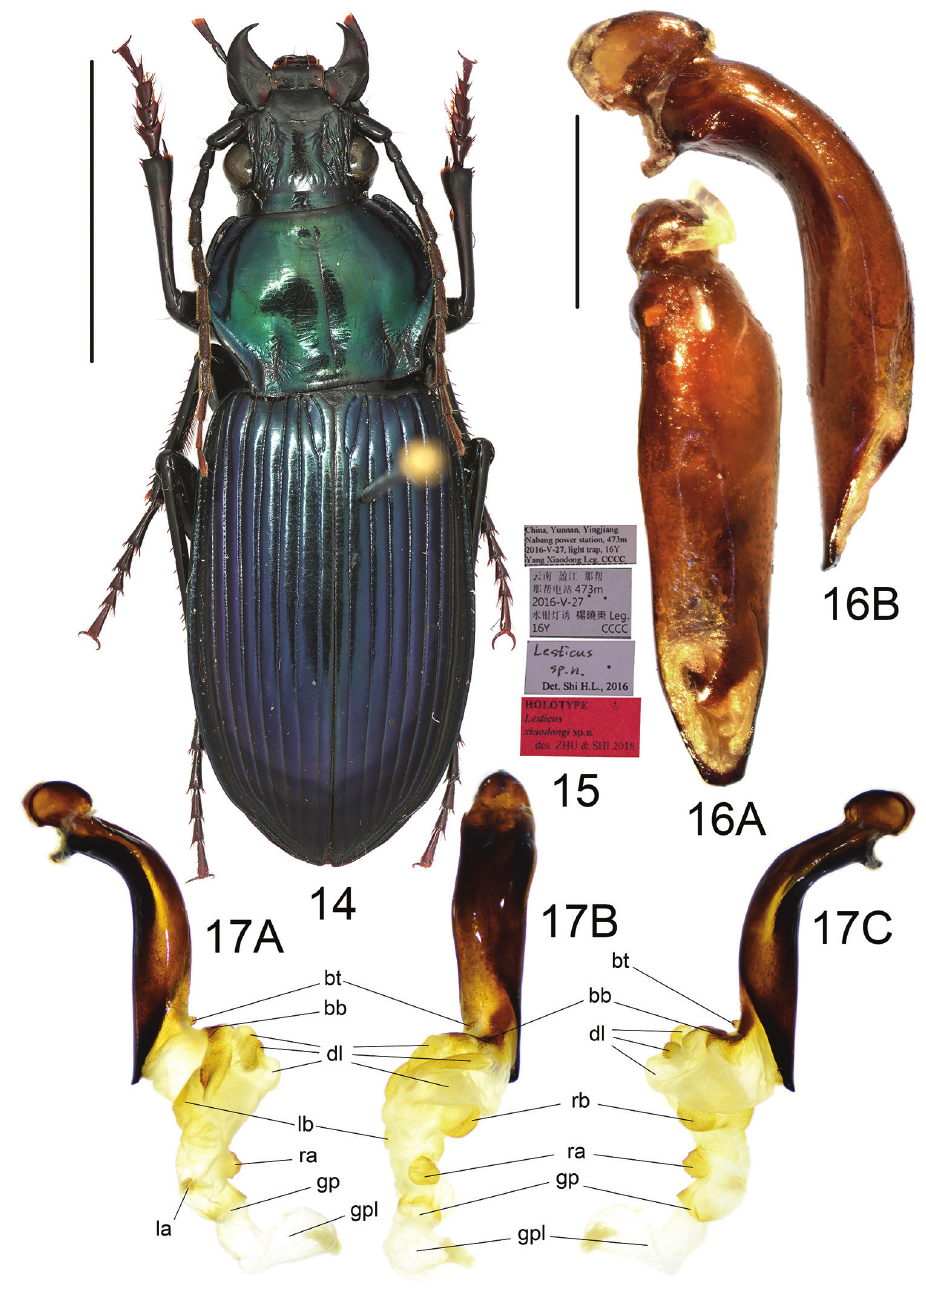
Figures 14–17. Lesticus xiaodongi sp. n. 14 habitus of holotype (male, Yunnan, IZAS), scale bar: 10.0 mm 15 labels of holotype 16 median lobe of aedeagus (holotype) A dorsal view B left-lateral view, scale bar: 2.0 mm 17 endophallus (holotype) A left lateral view B dorsal view C right lateral